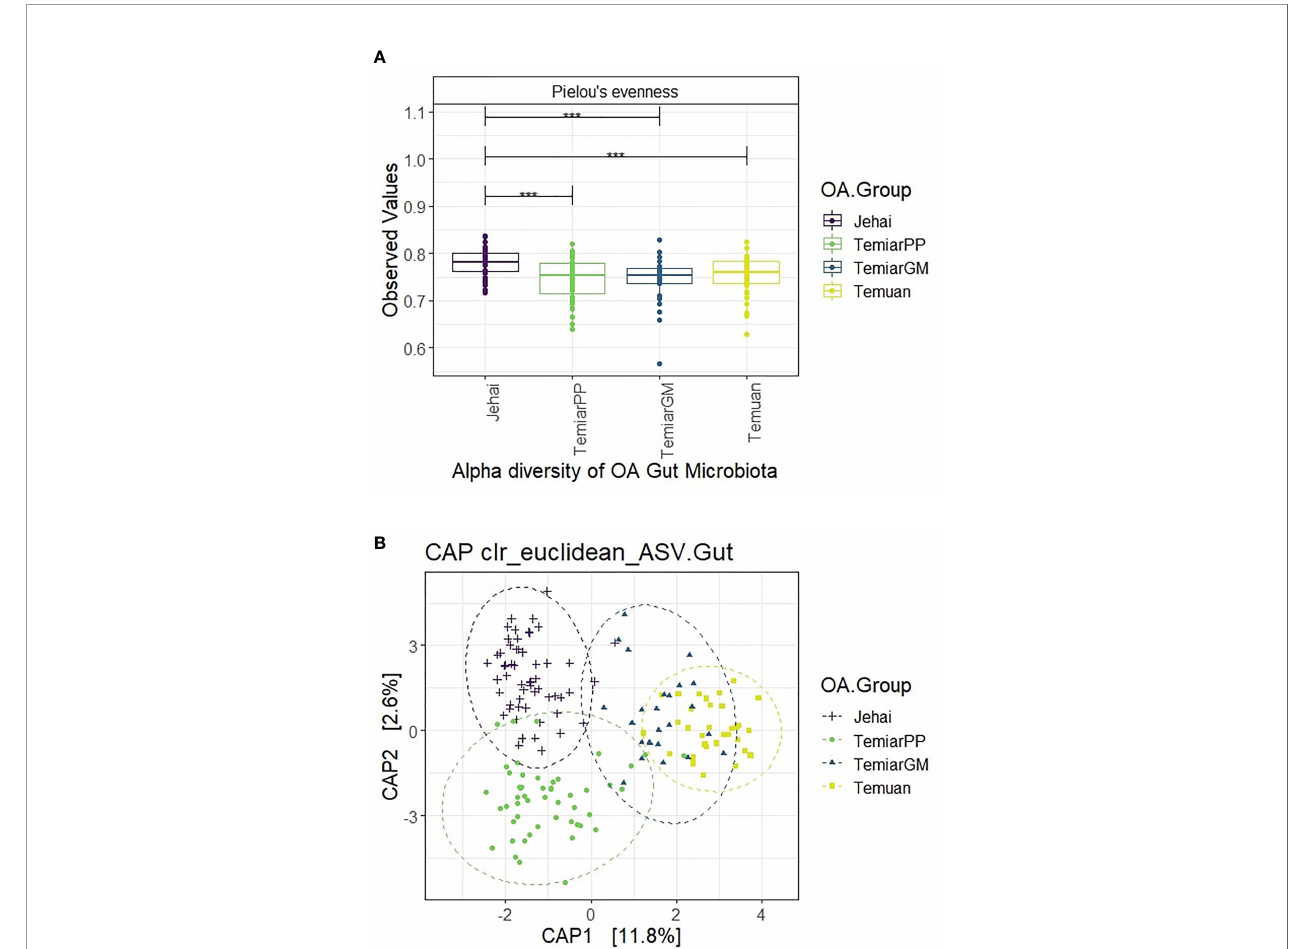
FIGURE 2 | (A) Semi-nomadic Jehai had the highest alpha diversity, while urban Temuan had the lowest (*** p-value < 0.001). (B) OA gut microbiota formed four distinct clusters with some